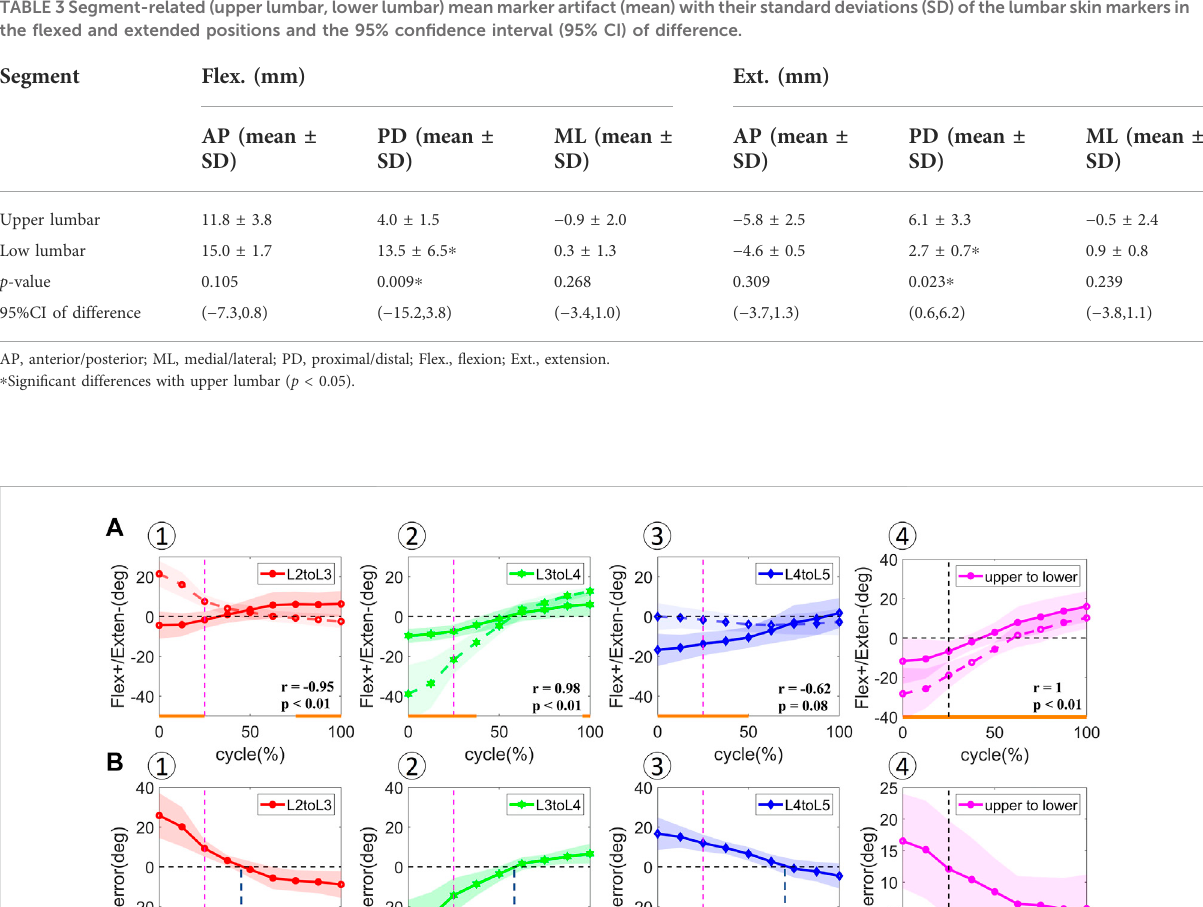
L4 – L5 levels, respectively ( p < 0.05). The zero kinematic errors of L2/L3, L3/L4, and L4/L5 under the two measurement methods are at 46%, 59%, and 72%, respectively (Figure 4), indicating that the skin movement characteristics of the upper and lower lumbar segments were different. These discrepancies can be explained by the skin deformation mechanism caused by complex lumbar muscle deformation. Second, it is speculated that the kinematic error of zero for the two measurements at 50% of the bending cycle occurs near the L3 level, which may be related to its anatomical and biomechanical characteristics because L3 is the apex of lumbar lordosis and the center of lumbar motion.